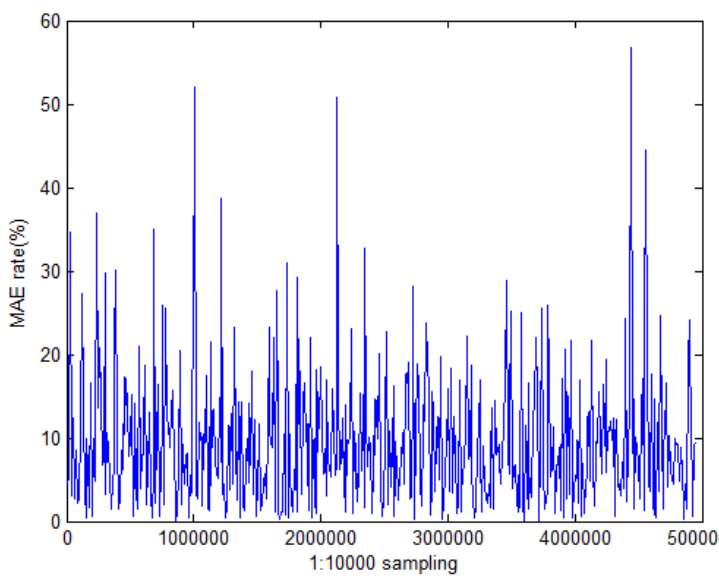
Fig. 4. MAE rate distribution of F 10.7 neural networks atmospheric model